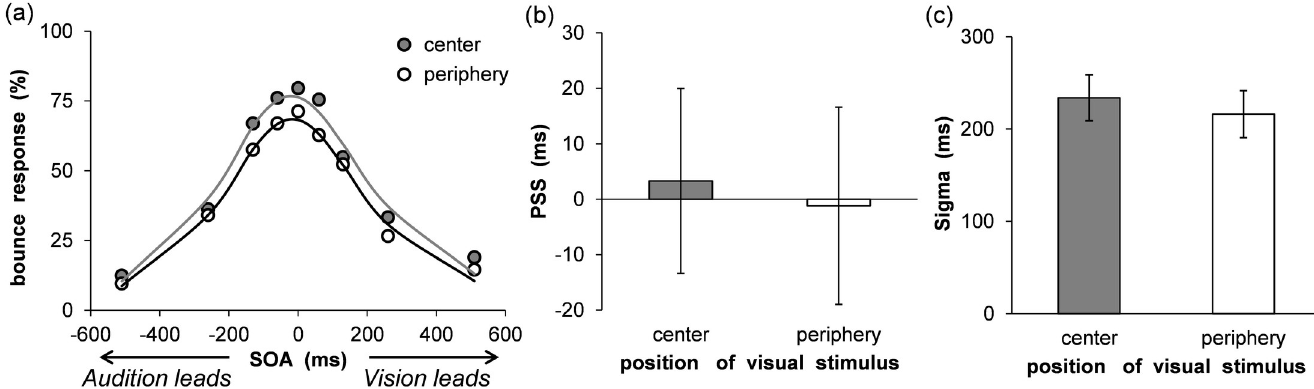
Fig 7. Results of synchrony perception analyses in Experiment 3. (a) Mean percentage of bounce responses. The average fitting functions are plotted for the central and peripheral visual field data. (b) Mean estimated point of subjective synchrony. (c) Mean estimated sigma. Error bars represent standard errors of the mean ( n =